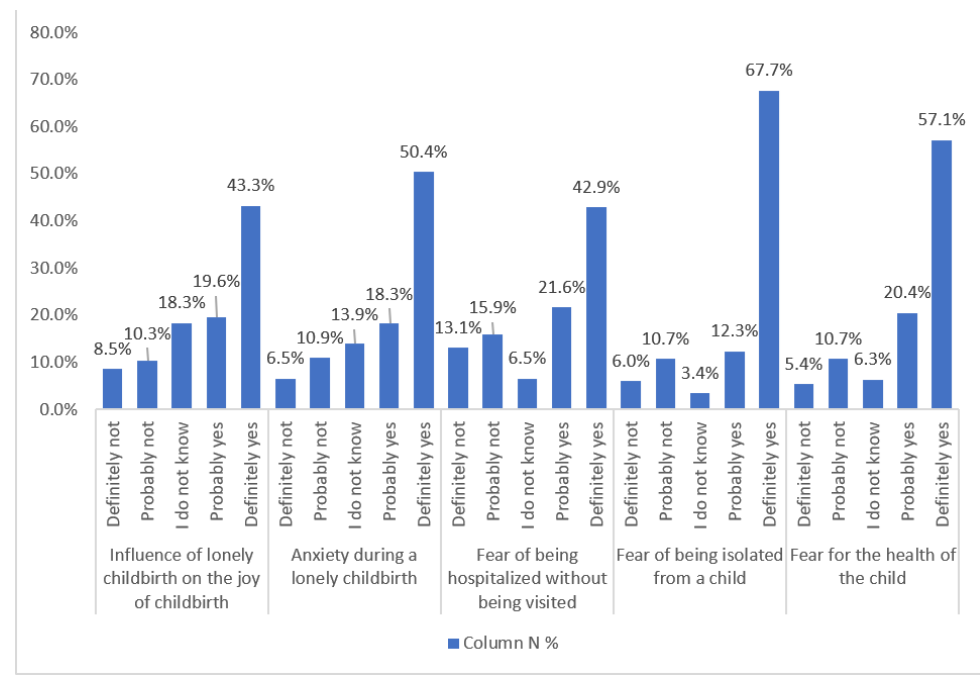
Figure 3. Emotions related with childbirth ( n =